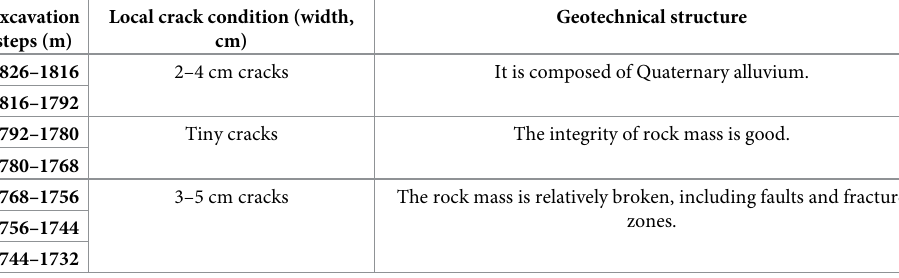
Table 1. Surface cracks and structural characteristics of rock